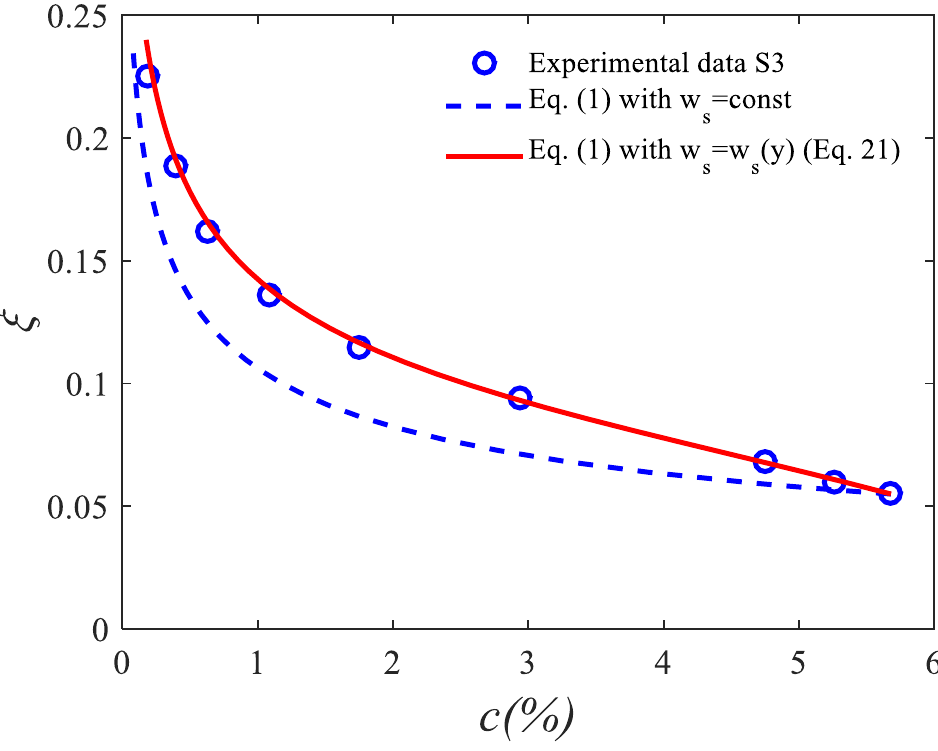
Figure 4 . Concentration profiles for coarse sediments (S3). Curves from numerical resolution of ADE (1) with 𝜈 𝑡 (𝑦) (5) C α = 0.477 and C 1 = 2.17 ; 𝛽(𝑦) from (9) and (13); dashed lines: constant settling velocity ω s = ω s0 = 0.1411m/s ; solid lines: ω s (y) = ω s0 f s (y) (21) 𝛼 𝑠 = 50 , ℎ 𝑠 = 0.019 ; symbols: experimental data.